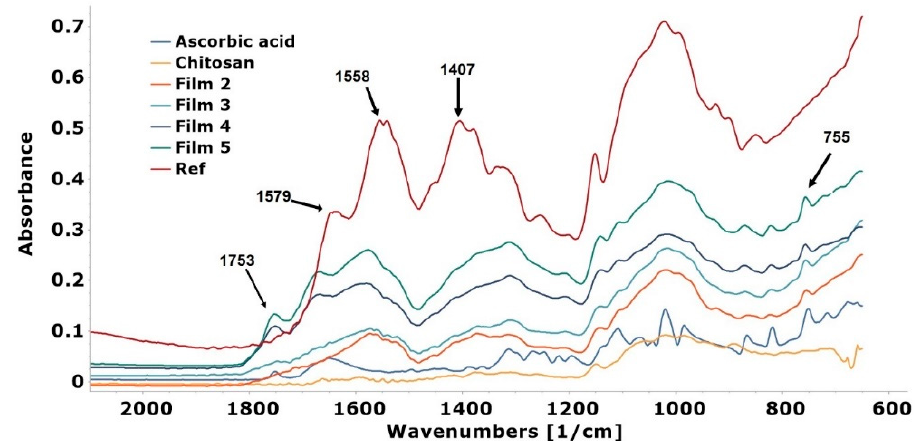
Figure 10. FTIR spectra of chitosan, ascorbic acid, and the films containing ascorbic acid.